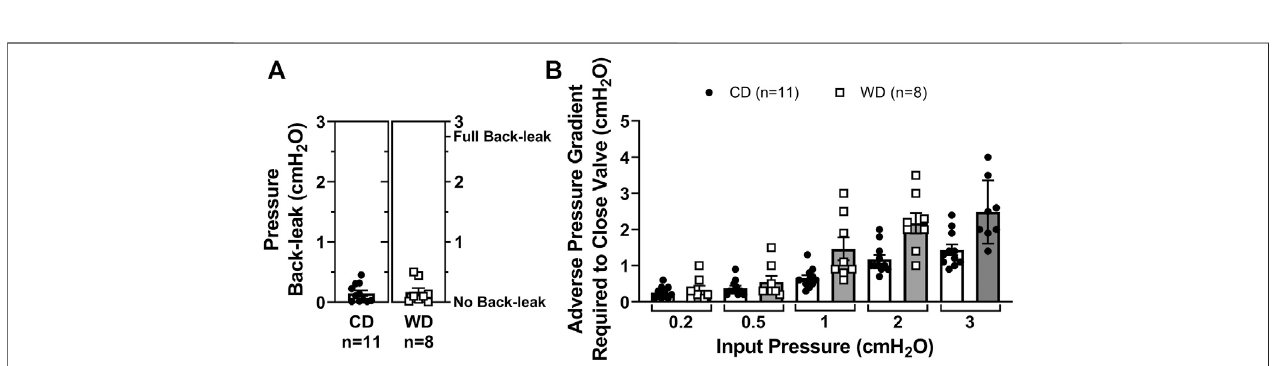
FIGURE 6 | Improved metabolic function in western diet-fed PAI-1 − / − mice prevents mesenteric lymphatic valve dysfunction. (A) Pressure back-leak measurements in mesenteric lymphatic valves from PAI-1 − / − mice fed a CD or a WD respectively. Each data point represents an individually tested valve. Multiple tests were performed, and resulting values were averaged for each valve; and (B) the adverse pressure gradient required to drive each speci fi c valve onto a closed position when P input was set and maintained at 5 different intraluminal baseline pressure levels (i.e., 0.2, 0.5, 1, 2, and 3 cmH 2 O). Data is presented as mean ± SEM. Datasets included in this fi gure were not normally distributed, therefore, statistical differences were evaluated using non-parametric t tests. No signi fi cant differences were